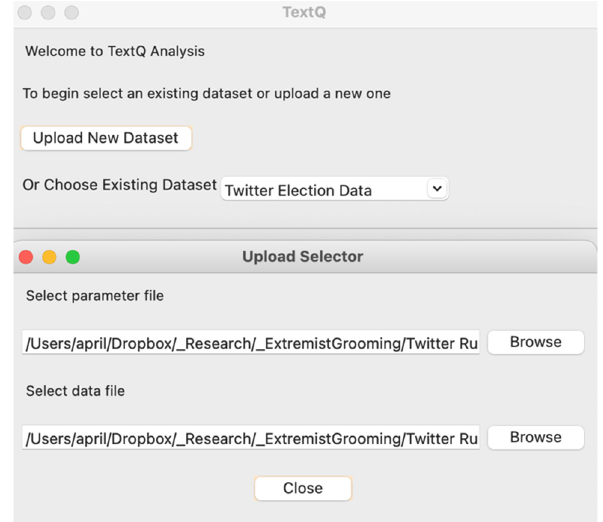
Figure 4. Beginning the process—specifying the input data sets.